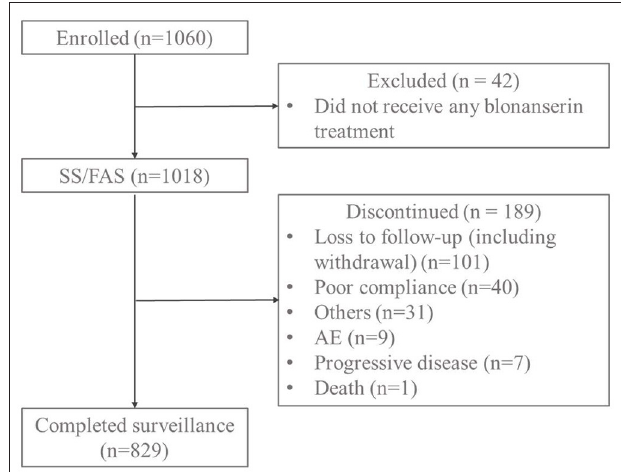
FIGURE 1 | Patient